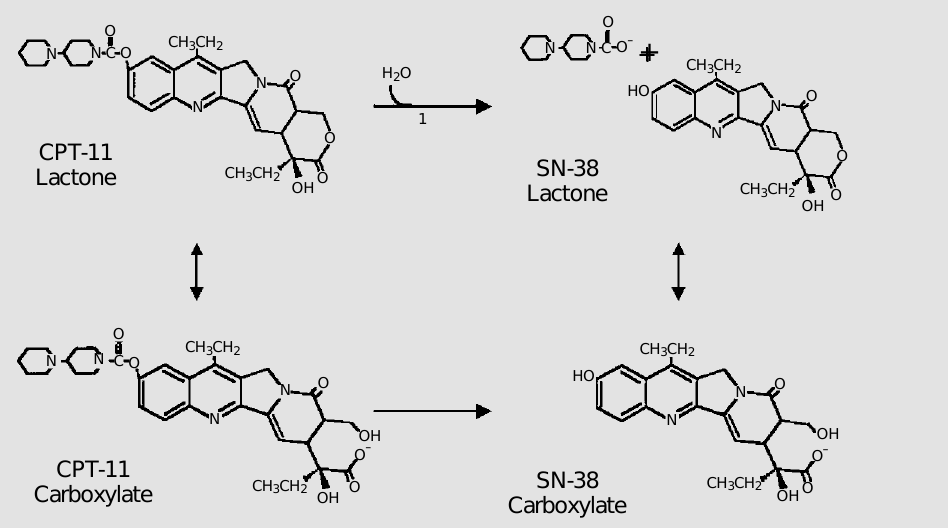
Figure 2. Metabolic conversion of irinotecan into SN-38. 1 : car- boxylesterase-converting en- zyme. Modified from Ref.